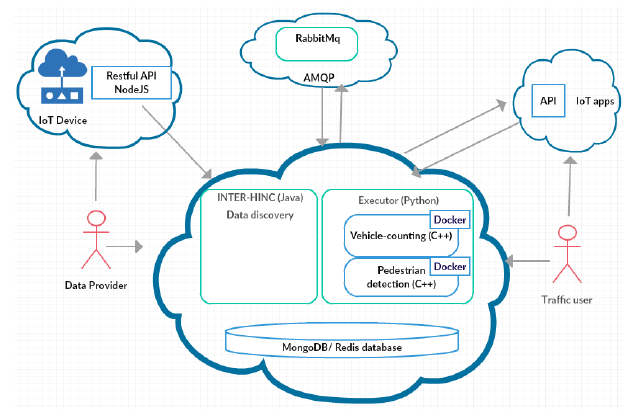
Figure 3. Haivan prototype